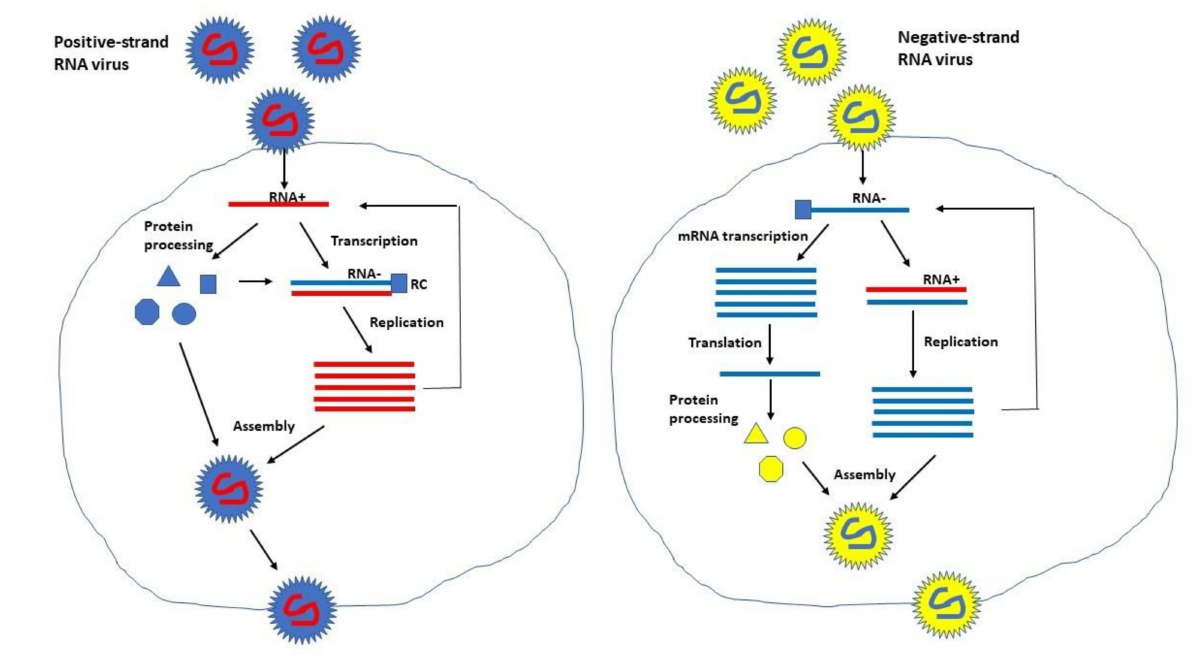
Figure 3. Replication strategy of positive- and negative-strand self-replicating RNA viruses. For positive-strand RNA viruses, the viral RNA is directly translated in the cytoplasm and replication of new positive-strand RNA copies require transcription of a negative-strand RNA template. In contrast, negative-strand RNA viruses rely on mRNA transcription before translation can take